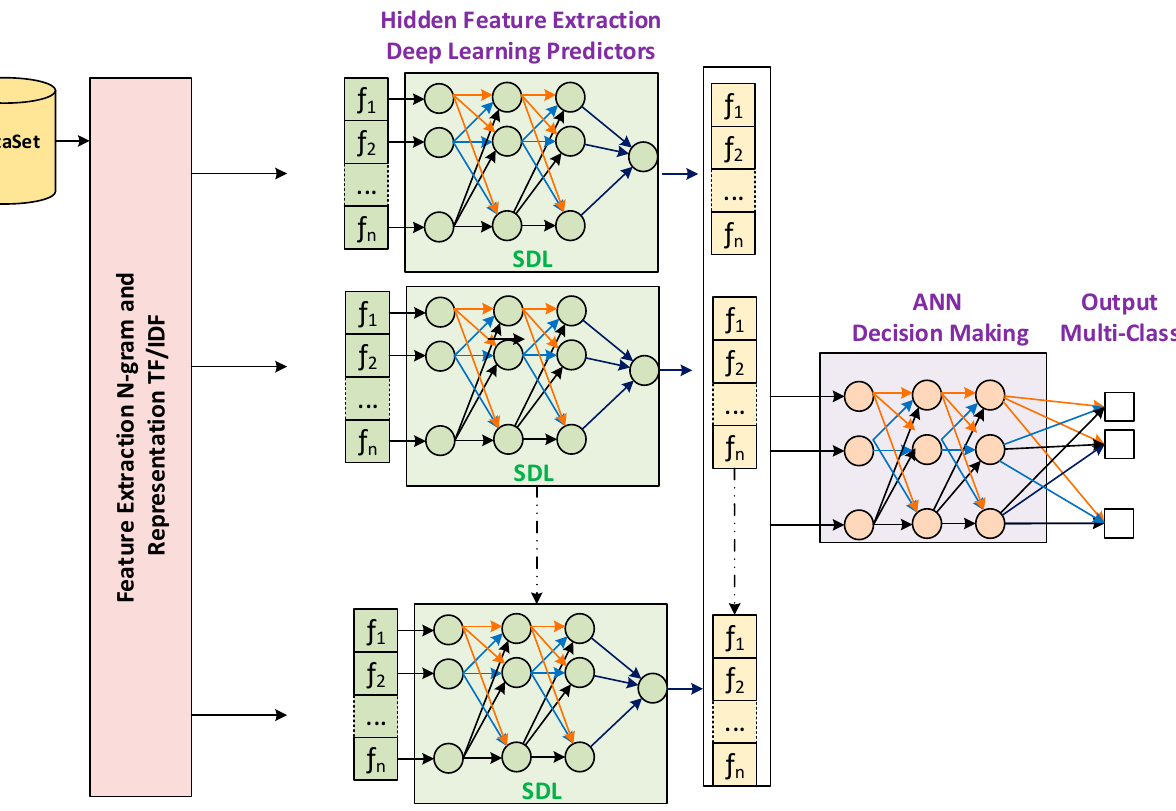
Figure 1. The proposed deep ensemble